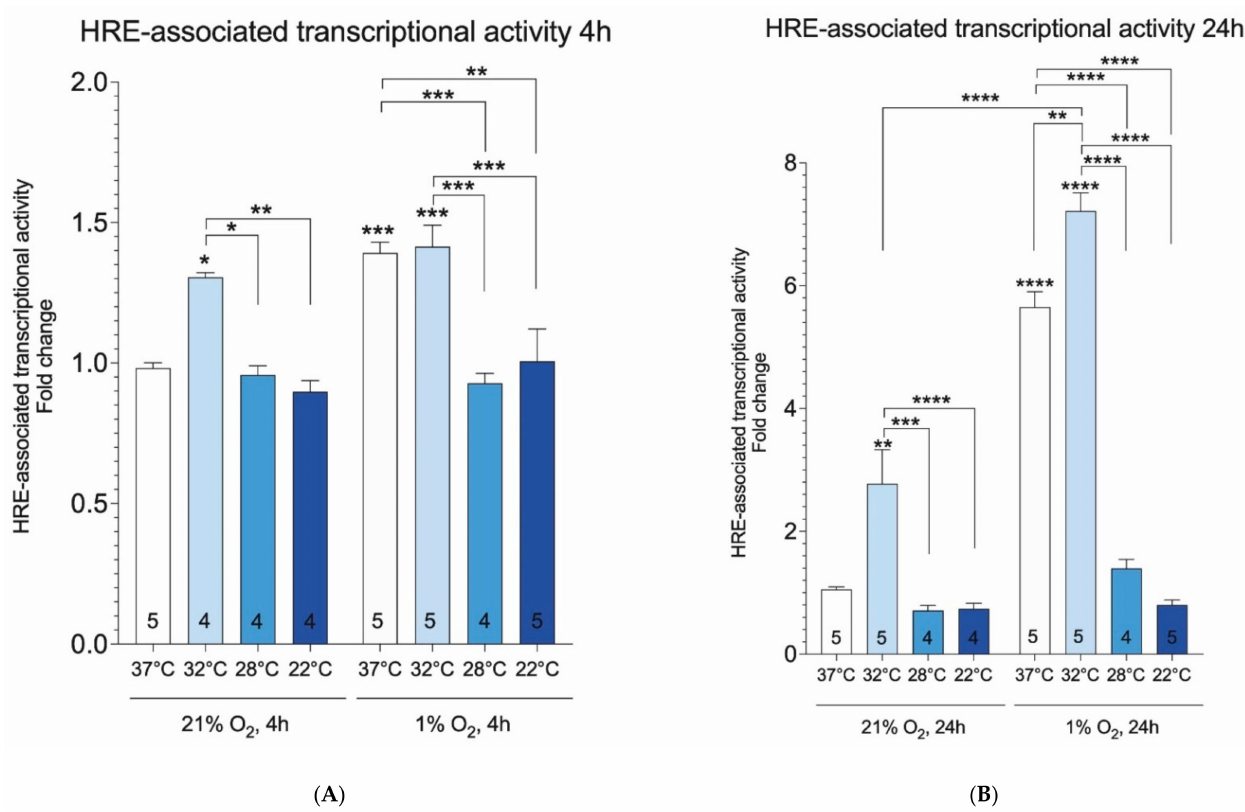
Figure 4. Transcriptional activity of HRE luciferase reporter at various temperatures and oxygen concentrations ( A , B ). Treatments were performed for 4 and 24 h. Results are normalized relative to 37 ◦ C group. Asterisks refer to a statistically significant difference with respect to 37 ◦ C control unless indicated otherwise. Numbers in bars indicate sample size. Values are expressed as mean ±